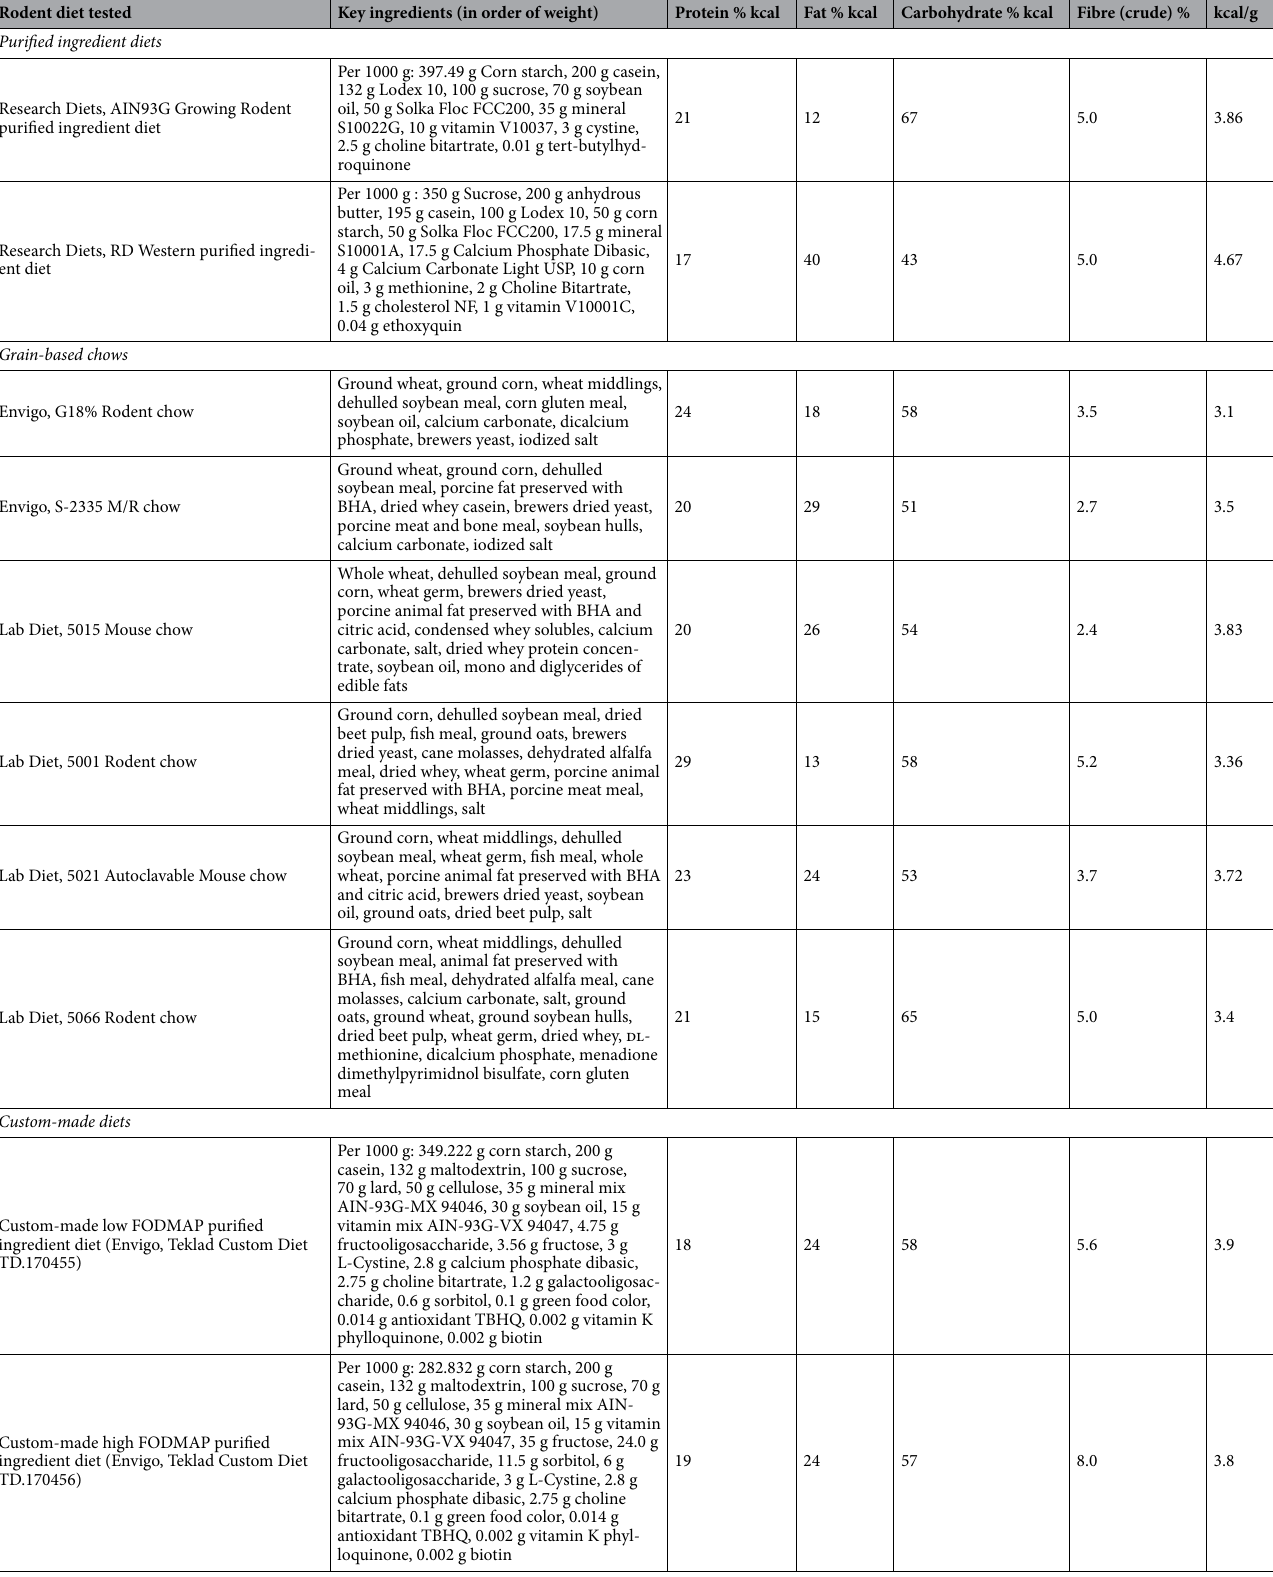
Table 1. Key ingredients and macronutrient composition of the commercially available rodent